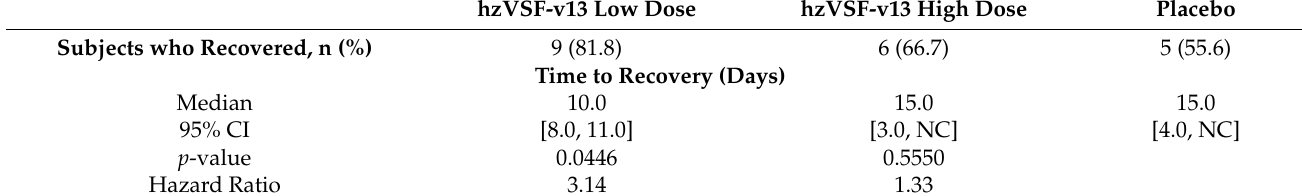
Table 6. Time to recovery in the severe stratum.